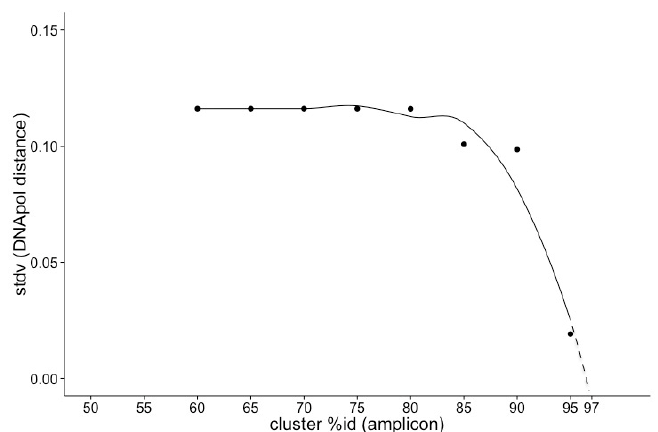
(DNApol) sequences, bootstrap values based on 1000 iterations; the scale bar represents the substitution rate.